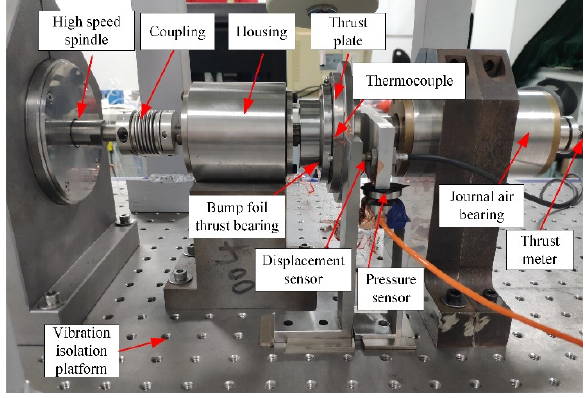
Figure 18. Thrust bearing temperature test bench.